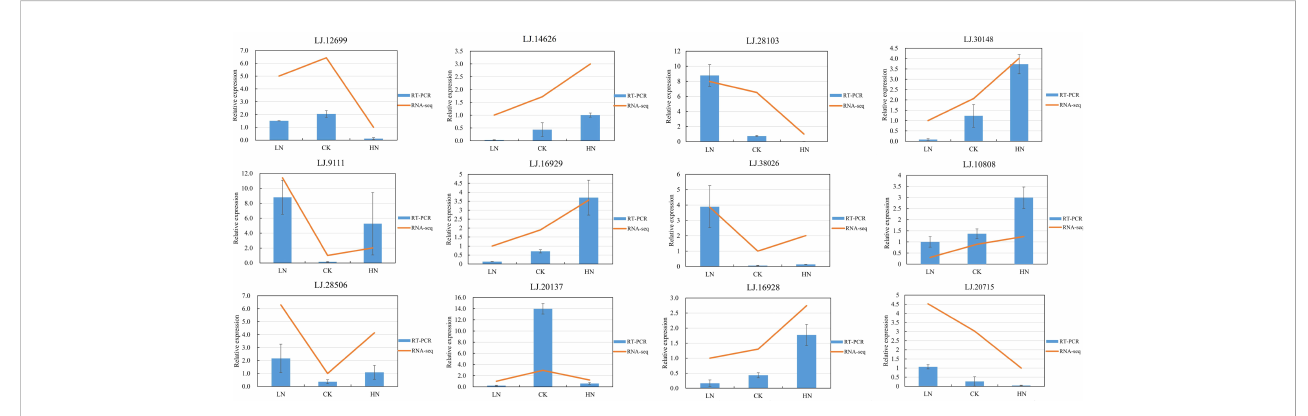
FIGURE 5 Comparison of expression pro fi les of selected lncRNAs as determined by Real